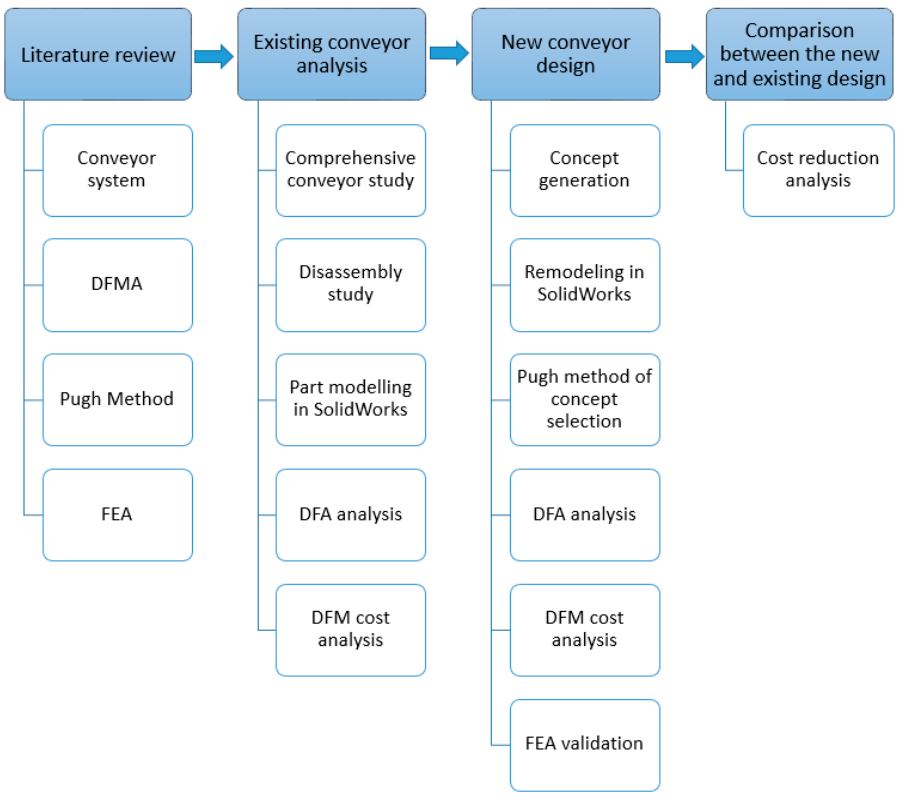
Figure 1. Design for Manufacture and Assembly (DFMA) implementation approach.